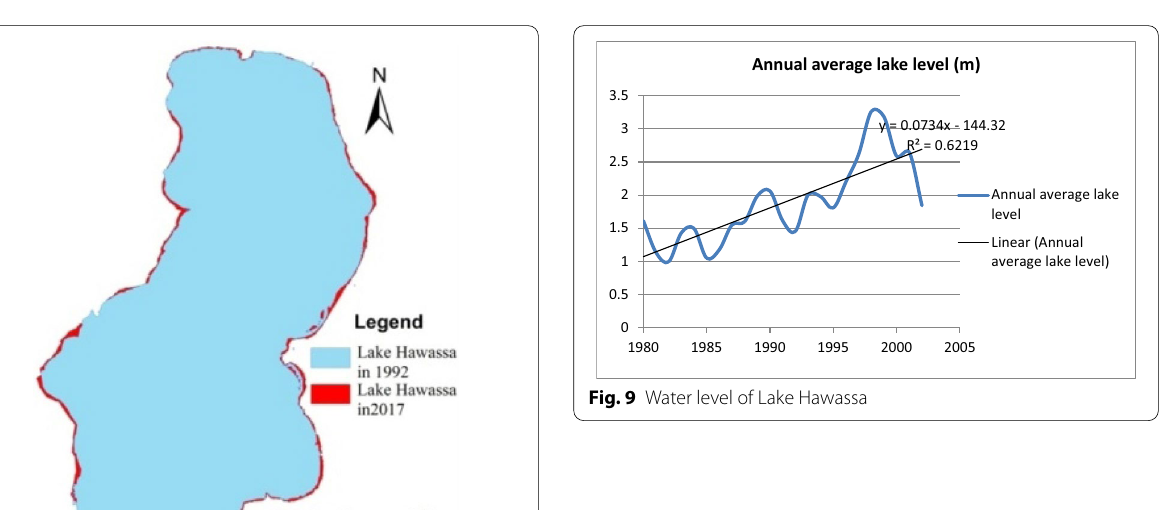
Fig. 7 Lake Cheleleka in 1992 and 2017